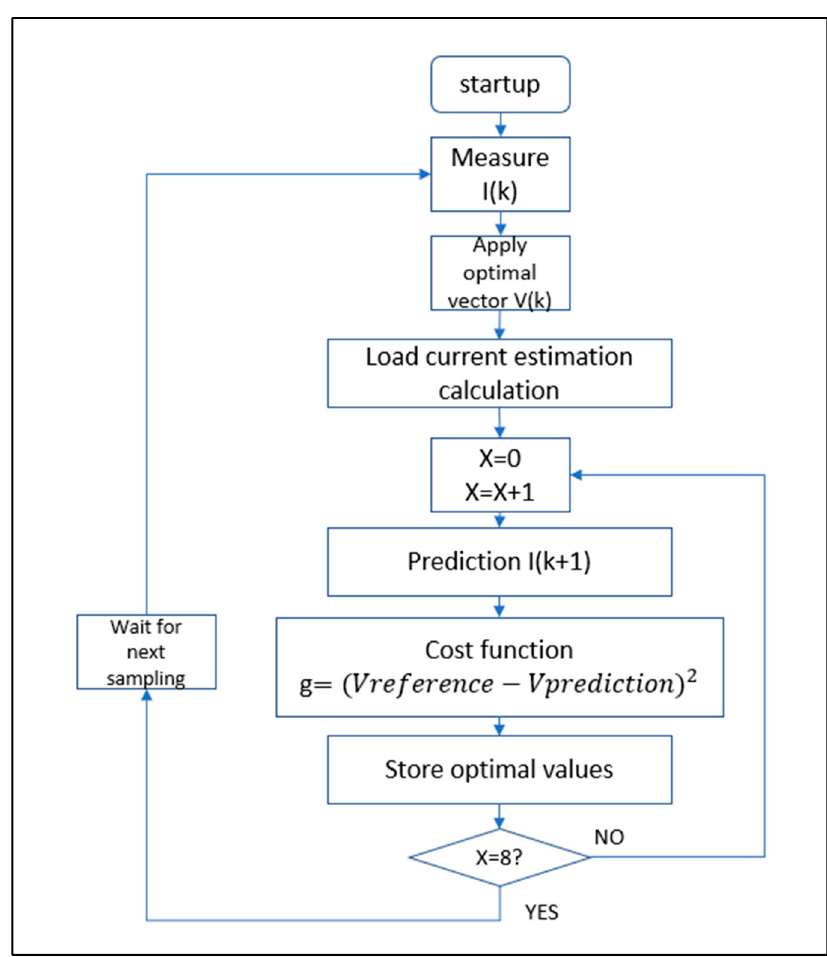
Figure 15. Flow chart of predictive current control with delay compensation.